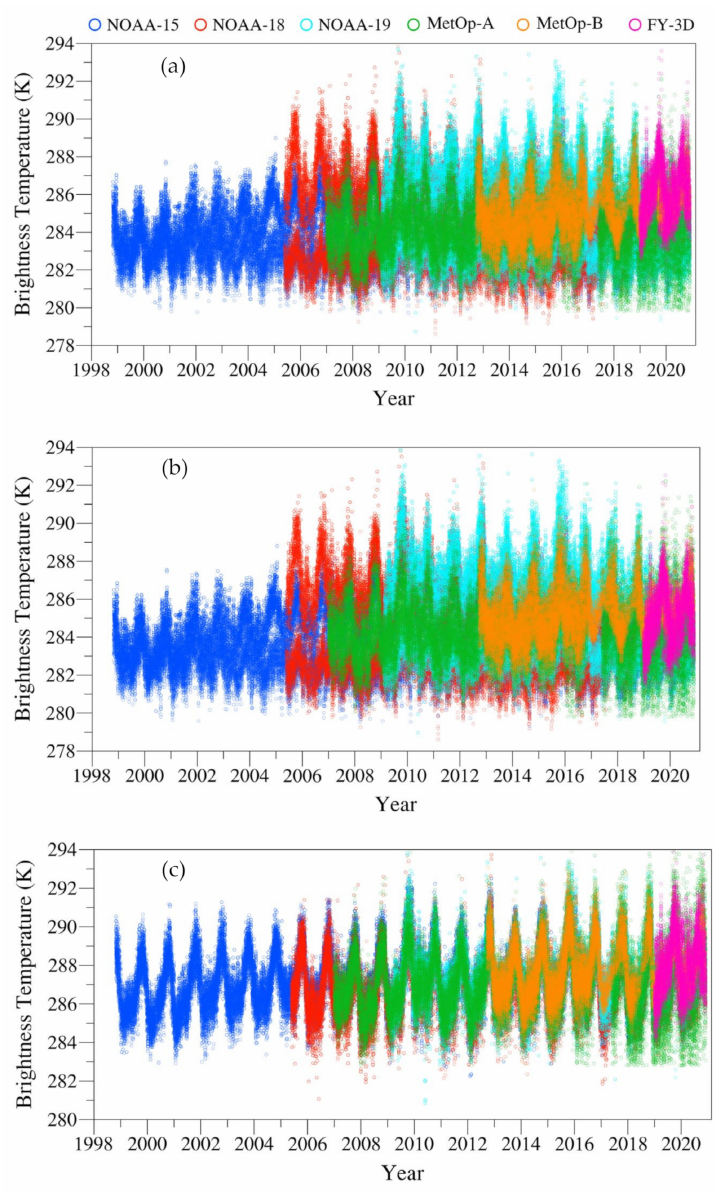
Figure 10. Time series of AMSU-A channel-3 brightness temperature observations from NOAA-15 (blue), -18 (red), -19 (cyan), MetOp-A (green), -B (orange), and FY-3d (magenta) ( a ) without any correction, ( b ) after inter-sensor bias correction, and ( c ) after inter-decadal diurnal